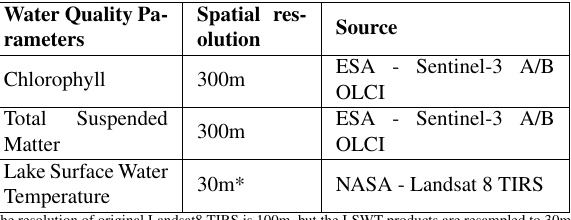
Table 1: Overview of the source data for WQP